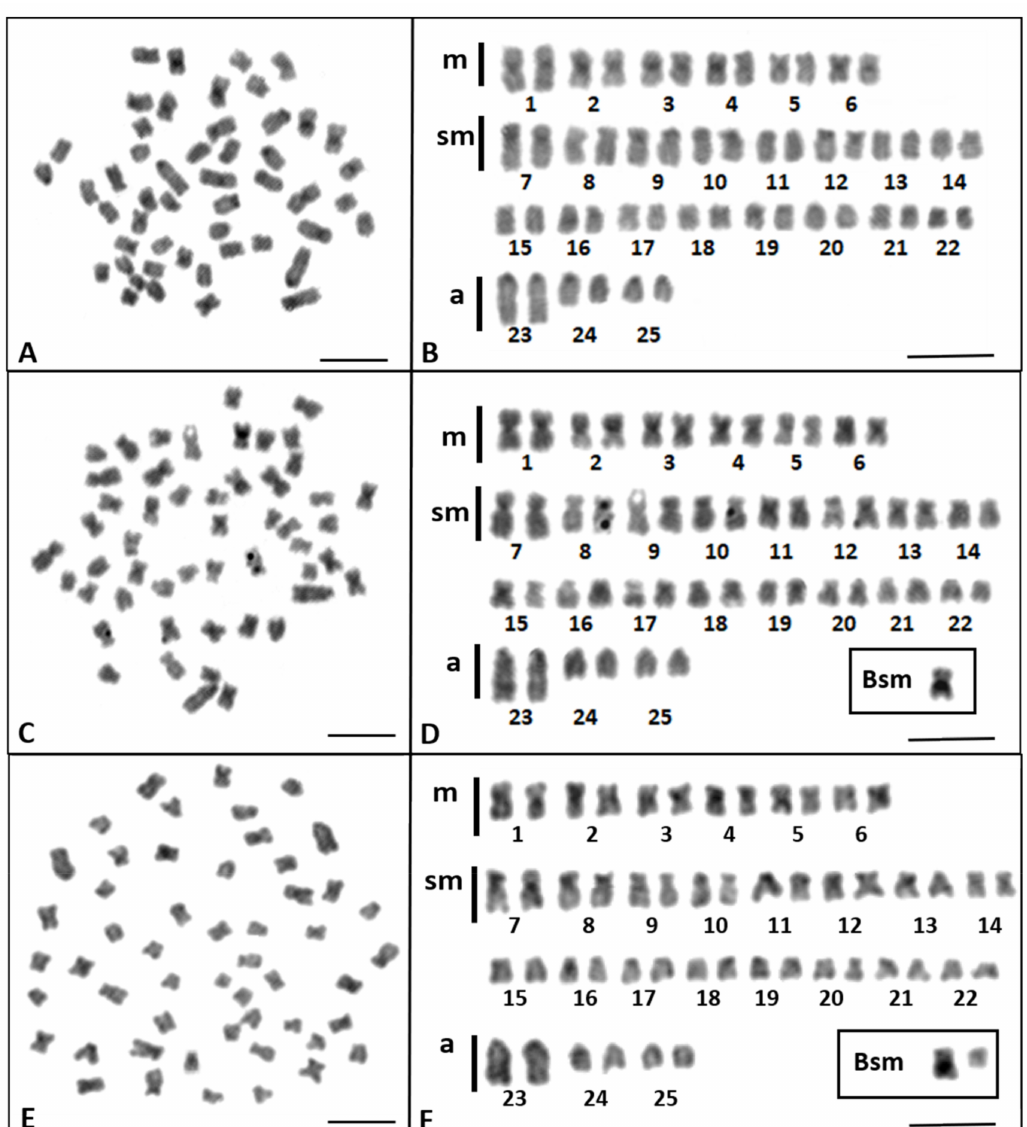
Figure 3. Metaphase plates and karyotypes of the common nase ( Chondrostoma nasus ) with 2 n = 50 chromosomes ( A , B ); 2 n = 51 chromosomes ( C , D ); and 2 n = 52 chromosomes ( E , F ) with C-banding; submetacentric B chromosomes (Bsm) are shown in Boxes. (Bar = 10 µ